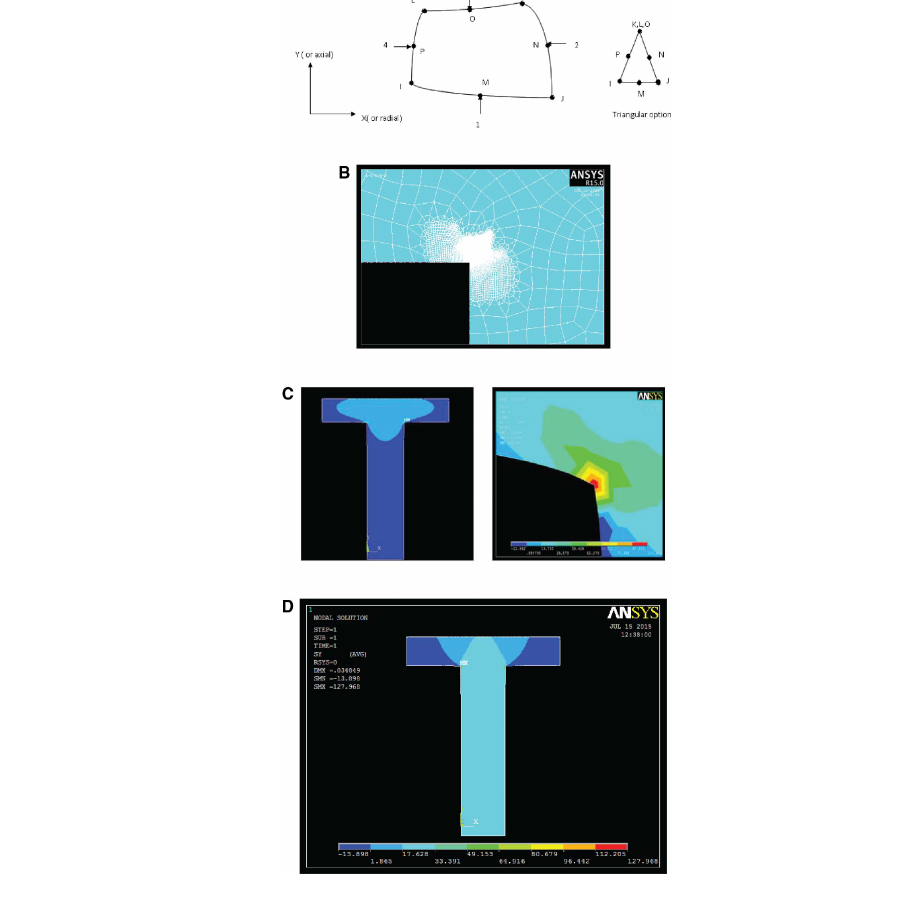
Figure 8: (A) Plane 183 element with 8-nodes. (B) Finite element meshing. (C) Stress distribution of the T-joint in the x direction. (D) Stress distribution of the T-joint in the y